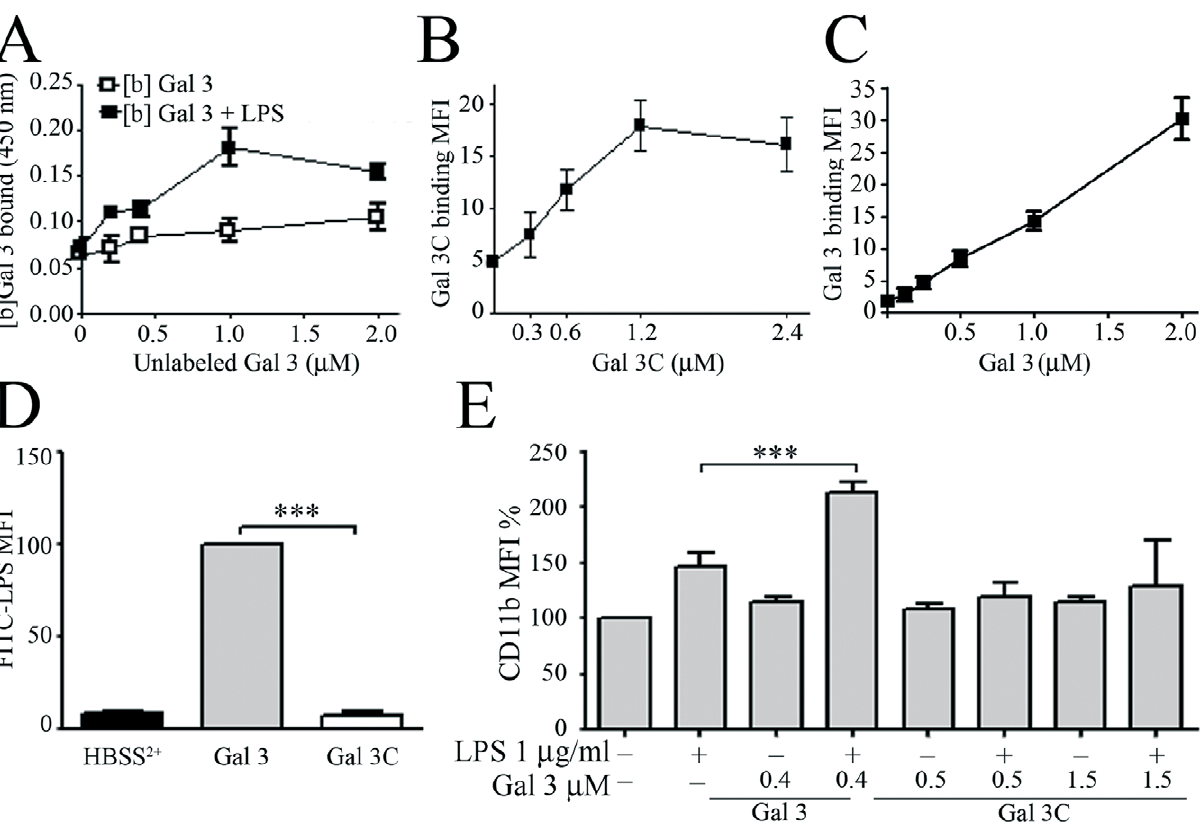
Figure 5. LPS induces oligomerization of Gal 3. A : A 96-well microplate was coated with 1 m g of recombinant Gal 3 per well. After blocking with gelatin 3%, 0.2 m M biotin-labeled Gal 3 ([b]Gal 3) and the indicated concentrations of unlabeled Gal 3 were added to each well in the presence (solid squares) or absence (open squares) of 5 m g/mL E. coli LPS. The signal was generated by neutravidin-HRP using OPD as a substrate. B and C : PMNs (2 6 10 6 /mL) were incubated for 30 min at 4 u C with increasing concentrations of truncated Galectin-3 (Gal 3C), lacking the N-terminal part ( B ), or increasing concentration of full-length Galectin-3 (Gal 3) ( C ). After washing, a specific polyclonal goat anti-Gal 3C ( B ) or goat anti-Gal 3 ( C ) and an FITC-labeled secondary anti-goat IgG antibody were used to detect Gal 3C on neutrophils by flow cytometry (n=2). D : PMNs (10 6 10 6 /mL) were treated for 20 min at 37 u C with FITC-LPS (12.5 m g/mL) preincubated with Gal 3 (8 m M) or with Gal 3C (8 m M). The binding of FITC-LPS was evaluated by flow cytometry as in figure 4. E : PMNs (2 6 10 6 /mL) were treated for 45 min at 37 u C with the indicated concentrations of full-length Gal 3 (Gal 3) or